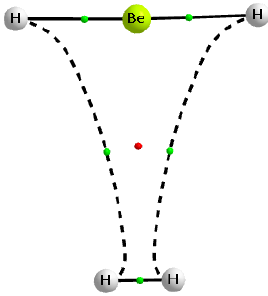
Figure 3. The molecular graph of the BeH 2 ··· H 2 complex; big circles correspond to attractors, small green circles to bond critical points, small red circle to the ring critical point, and continuous and broken lines to bond paths.